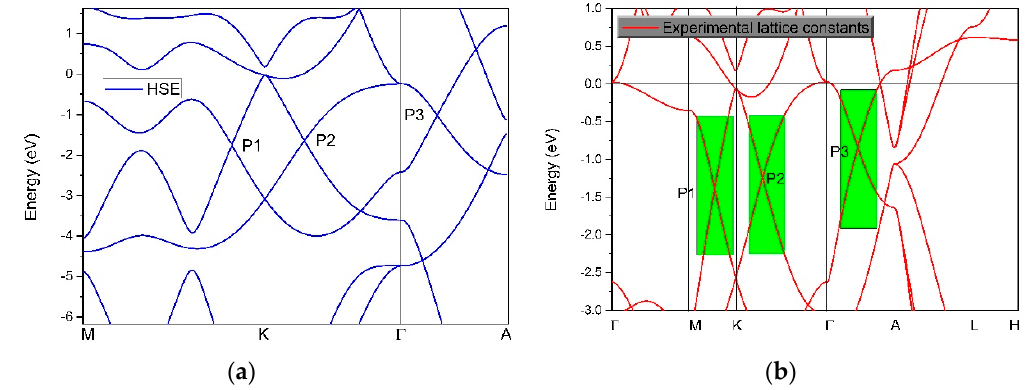
Figure 4. ( a ) The band structure of CrB 2 calculated using the hybrid functional (HSE06) method and ( b ) the band structure of CrB 2 using the generalized gradient approximation (GGA) method under experimental lattice constants.